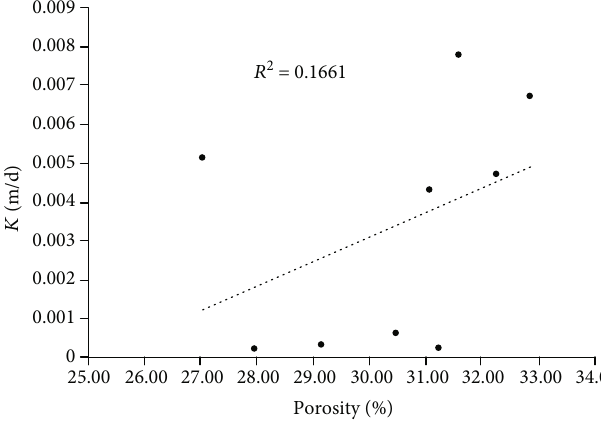
Figure 8: Correlation curves of the hydraulic conductivity and porosity. Table 7: The average pore-throat radius of samples before and after the seepage experiments.